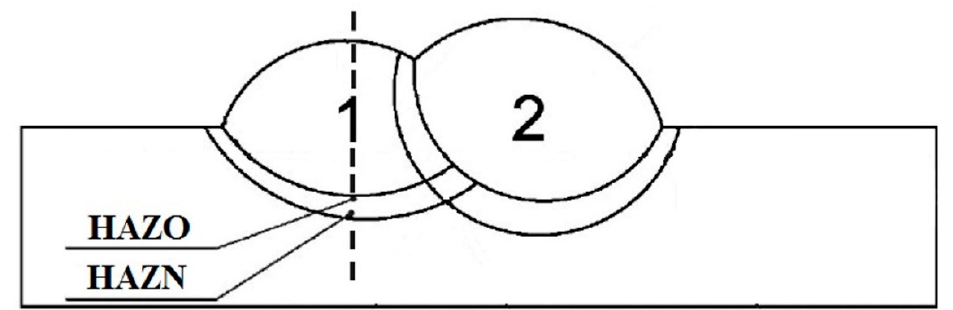
Figure 3. Hardness measurement areas of the heat affected zone (HAZ)—TBW specimens, overheated area of HAZ (HAZO) of the 1st padding weld in the weld axis, normalization area of HAZ (HAZN) of the 1st padding weld in the weld axis.